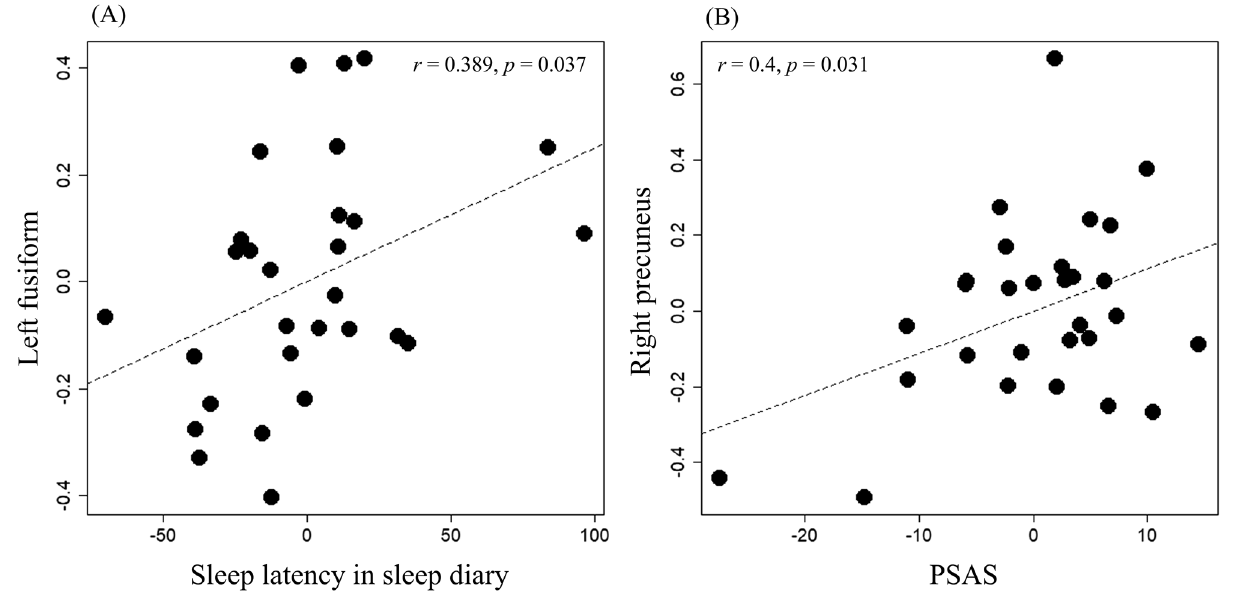
Figure 2. Partial correlations between clinical data and BOLD activation in the ROIs. The partial correlation ( A ) between sleep latency from the sleep diary and BOLD signal activation in the left fusiform ( r = 0.389, p = 0.037) and ( B ) between PSAS and in the right precuneus ( r = 0.4, p = 0.031) were statistically significant, respectively. BOLD blood oxygen level dependent, ROI region of interest, PSAS pre-sleep arousal